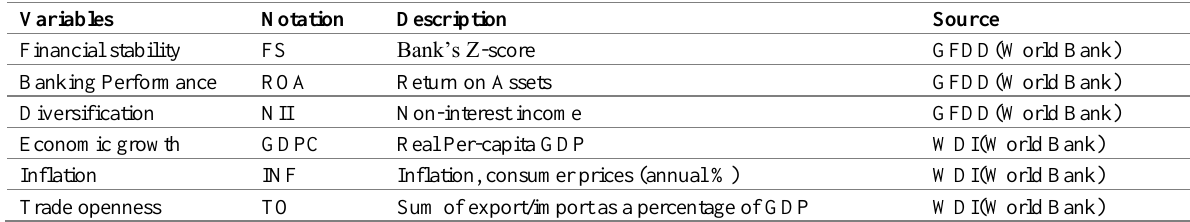
Table 1: Data Description and